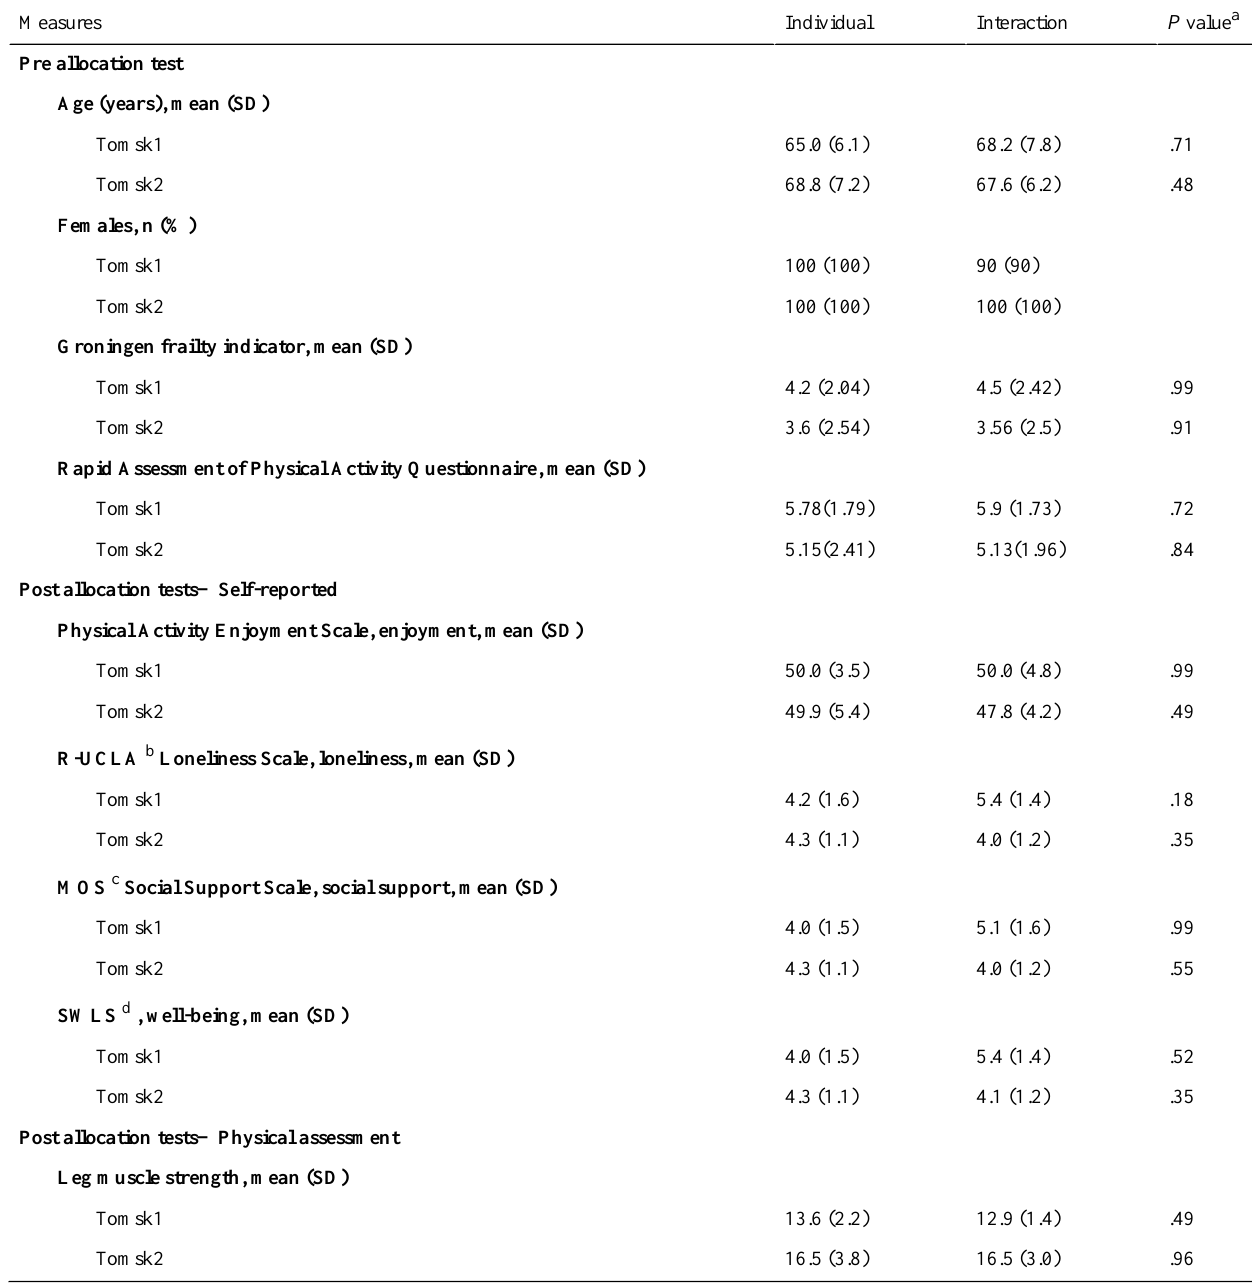
Table 2. Baseline measures for study site. Tomsk1 and Tomsk2.